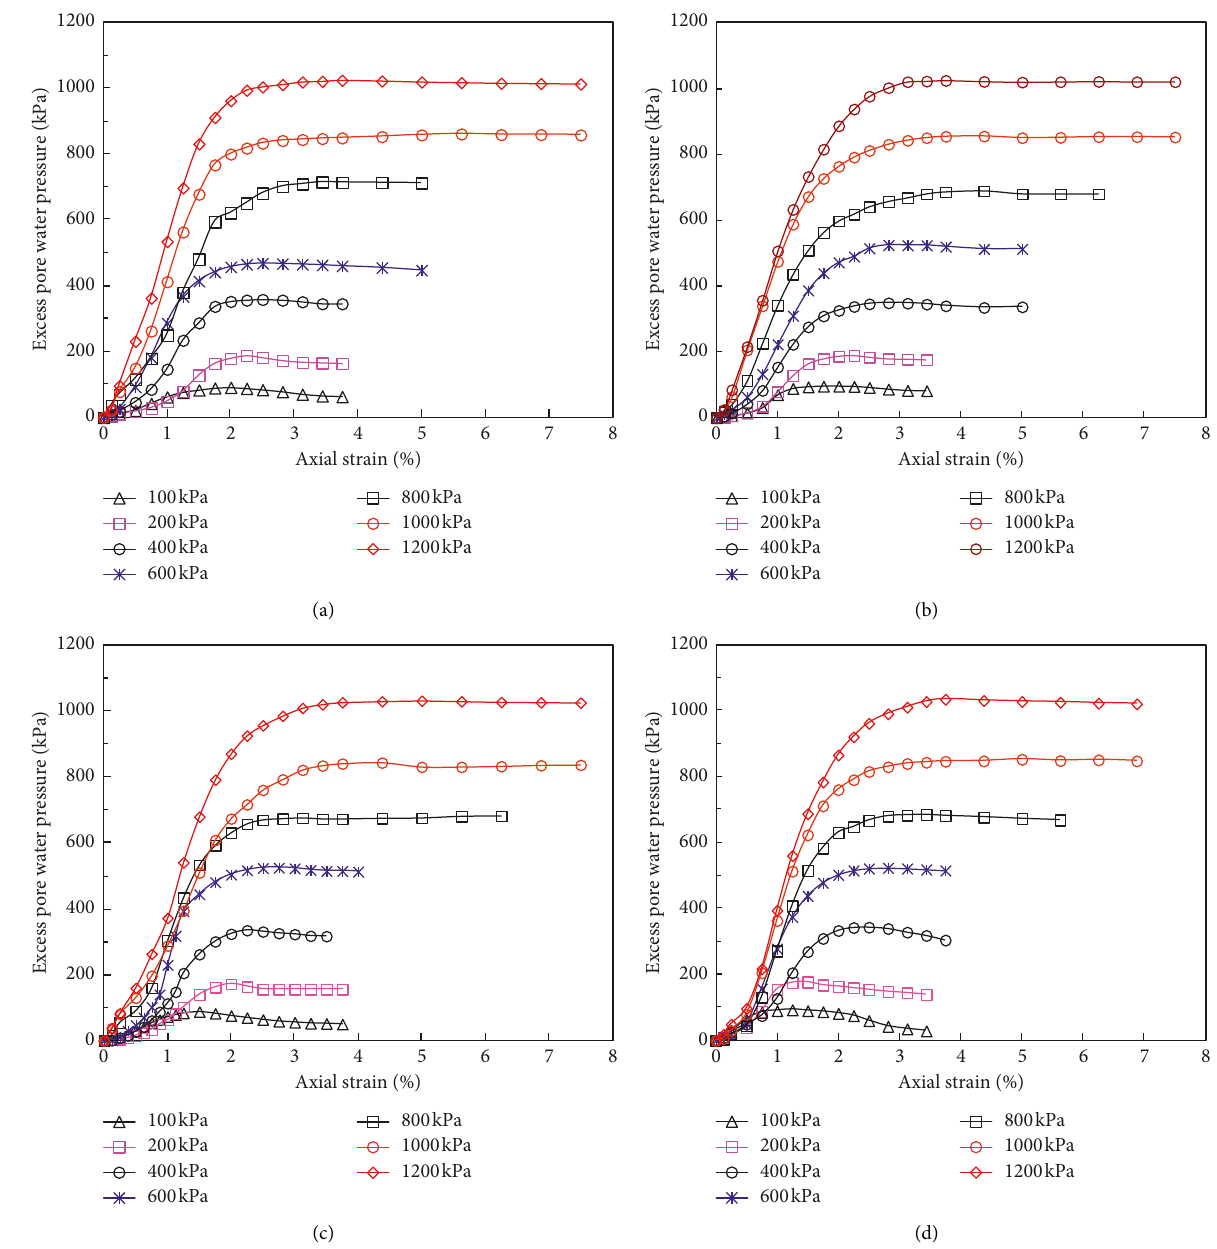
Figure 6: Relationship between excess pore water pressure and axial strain at different applied confining pressures: (a) 2.5W+C100+P40, (b) 3.0W+C100+P70, (c) 3.0W+C200, and (d)